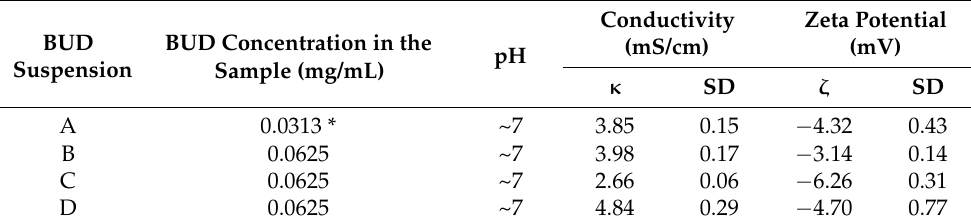
* More diluted because of too-high electrolyte concentration for the reliable ζ measurement.